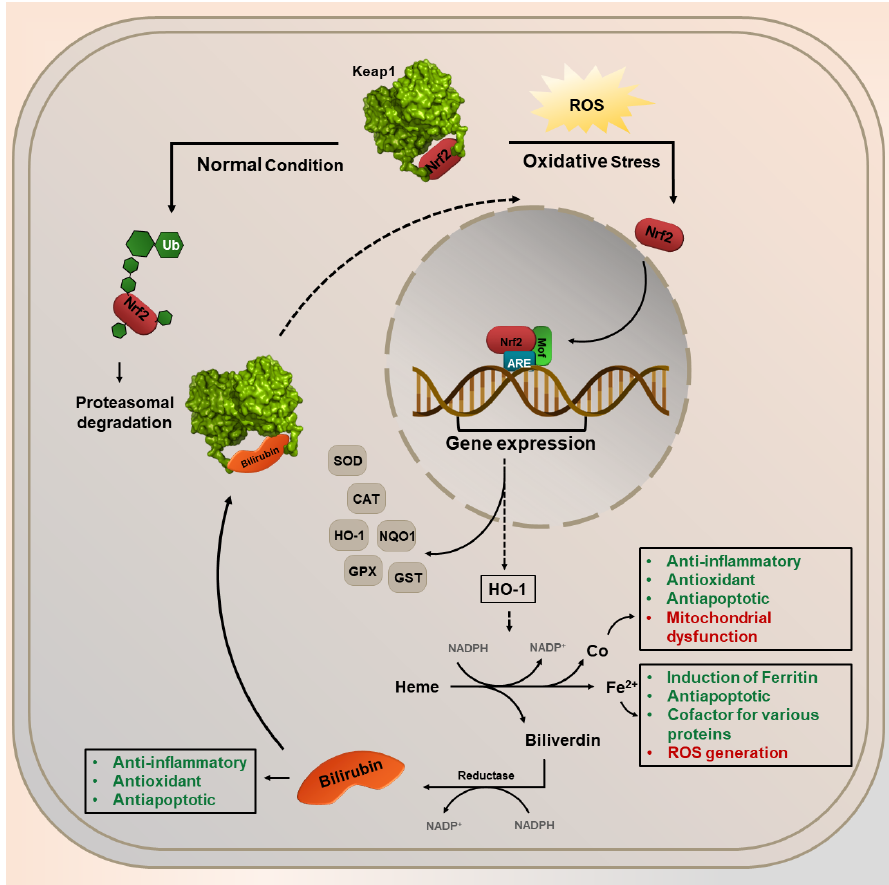
Figure 1. Nrf2/HO-1 axis activity in oxidative conditions. Nuclear localization of Nrf2 in oxidative conditions triggers several antioxidative proteins. HO-1 is an essential enzyme in the degradation of heme and the production of some functional components. These compounds display various beneficial (in green) and harmful (in red) effects on cells.